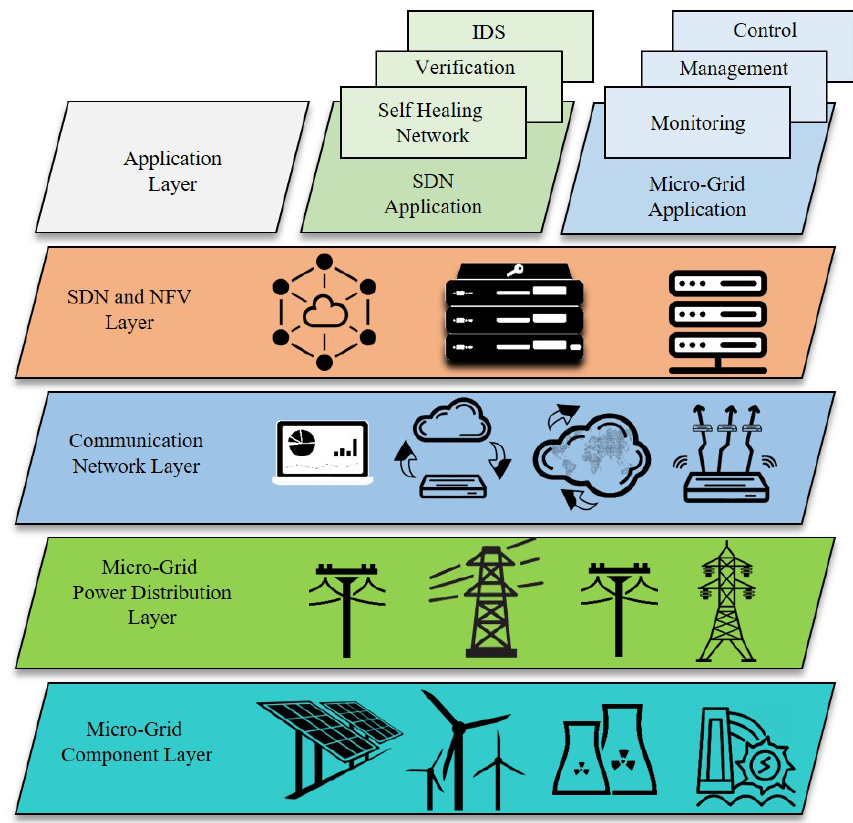
Figure 1. Basic IoE Framework. [Integration of information and communications technology (ICT), cybersecurity, encryption, cloud computing, and energy systems to form Internet-of-Energy